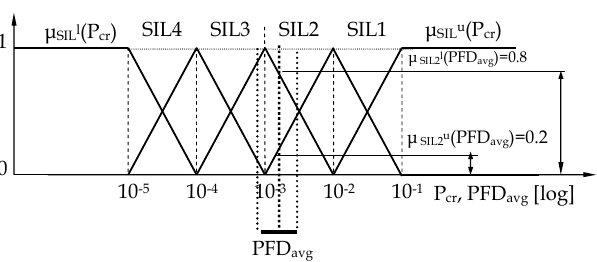
Figure 19. Verification of safety integrity level for a point value of PFD avg .